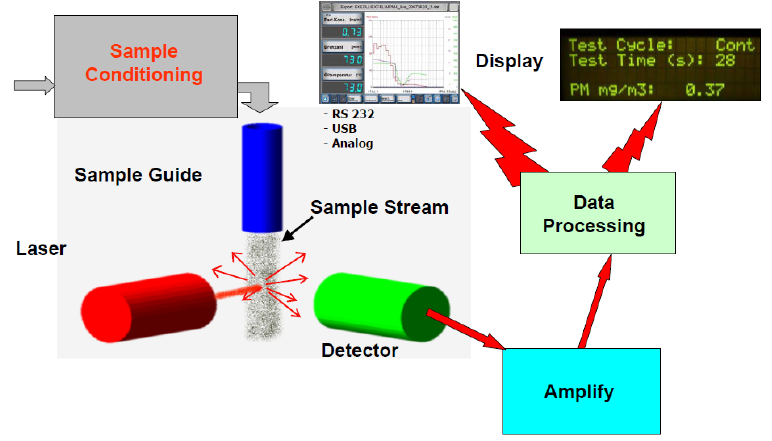
Figure 4. The idea of LLSP — laser light scattering photometry — method used in MPM4 The idea of LLSP—laser light scattering photometry—method used in MPM4 (MPM4_New.pdf). (MPM4_New.pdf).